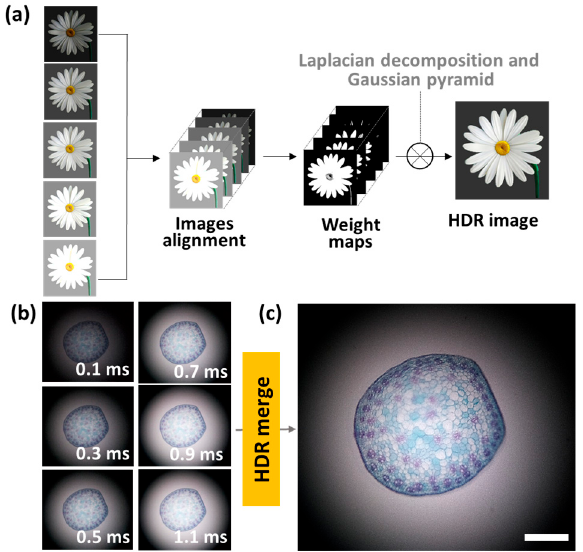
Figure 6. High dynamic range (HDR) imaging of MCM. ( a ) An algorithm flow chart of HDR reconstruction. ( b ) Sectional images of monocotyledonous plant stem according to exposure times. ( c ) A reconstructed HDR image by integrating the various contrast images. The scale bar is 100 µ m.